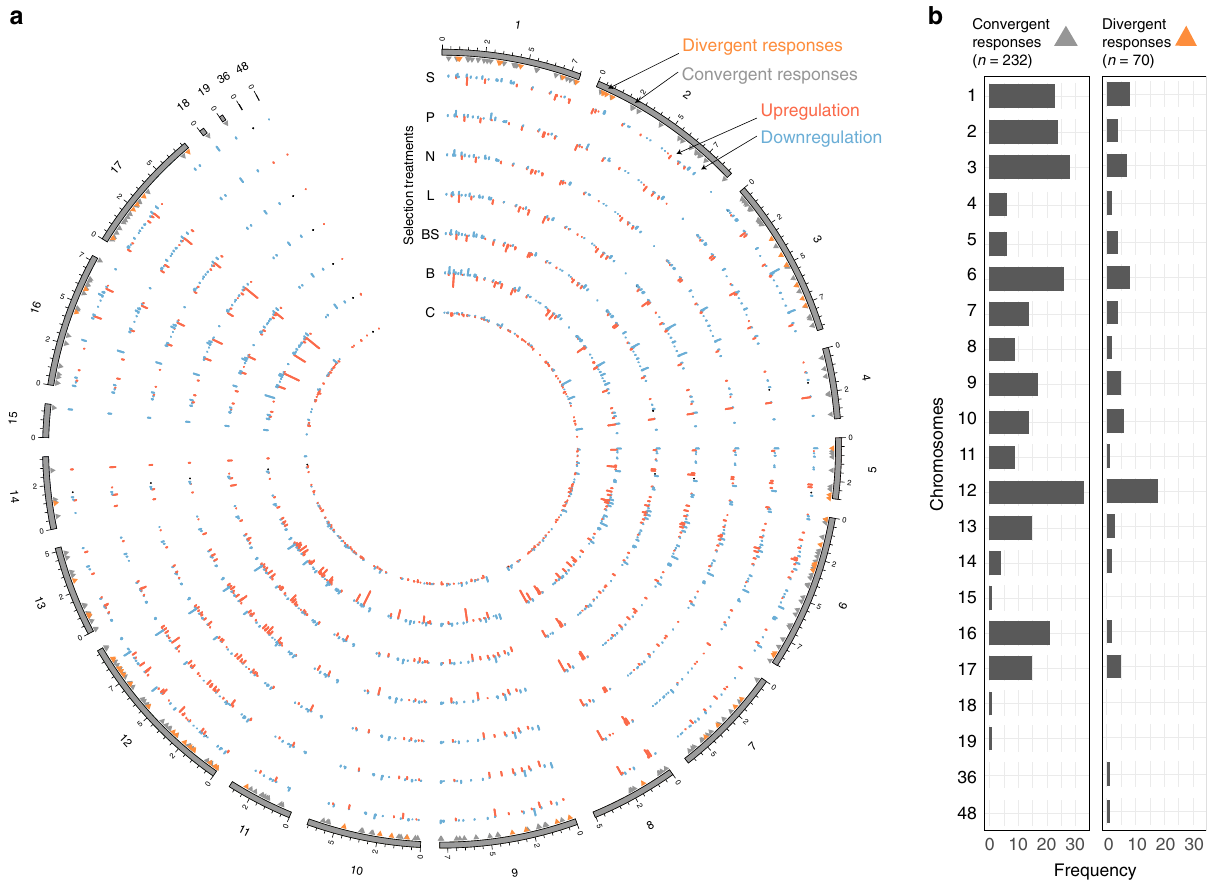
Fig. 2 Chromosomal loci of the differentially expressed proteins. a Proteins where the expression of at least one treatment is signi fi cantly different from the ancestors ( t test p < 0.01; n = 1304; 39% of the total detected proteins). b Among these, 351 proteins exhibit a differential response from the control (Dunnett test p < 0.05). These differentially expressed proteins classify into divergent (Friedman test p < 0.1; n = 70) and convergent responses (Friedman test p > = 0.1; n = 232). Both convergent and divergent responses are non-randomly distributed across the chromosomes (chi-square test; p <